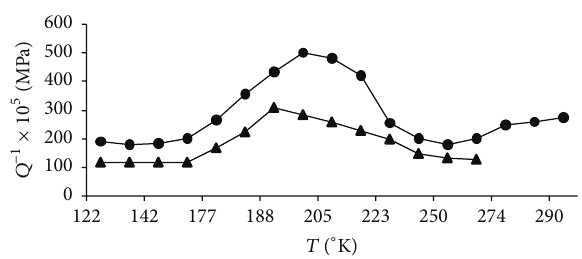
Figure 6: Temperature curve of internal friction of the testing steel.